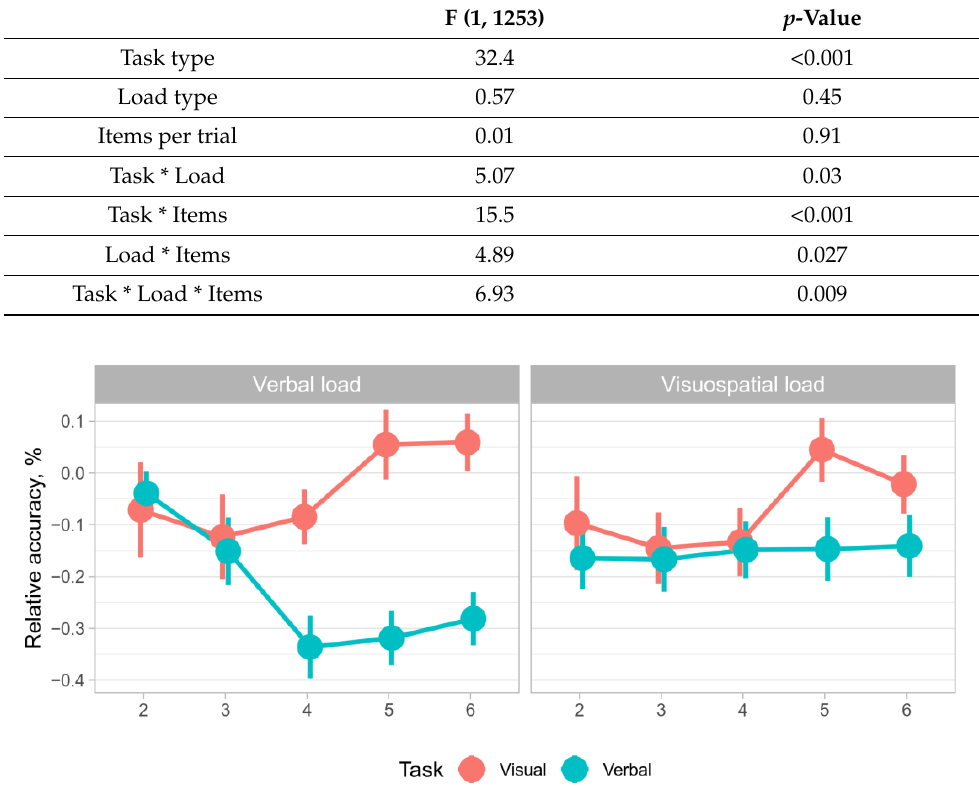
Figure 4. The two-way ANOVA results of the experimental sessions grouped by the number of items per trial. Experimental sessions including 2 – 3 trials. A two-way ANOVA didn ’ t reveal a sig- nificant interaction between factors (F (1, 504) = 0.3, p > 0.05). The results also showed that the cognitive load type had no effect on the RA of the WM span task performance (F (1, 504) = 1.21, p > 0.05). The two-way ANOVA results are shown in Figure 2. The Wilcoxon non-parametric test results showed that there was no significant RA difference between cognitive load type levels (Z = − 1.230, p > 0.05) and between the WM span task levels (Z = − 0.332, p > 0.05). Two-way ANOVA results of the experimental sessions including 4 – 6 trials showed that the RA of WM span task performance varied depending on cognitive load type.